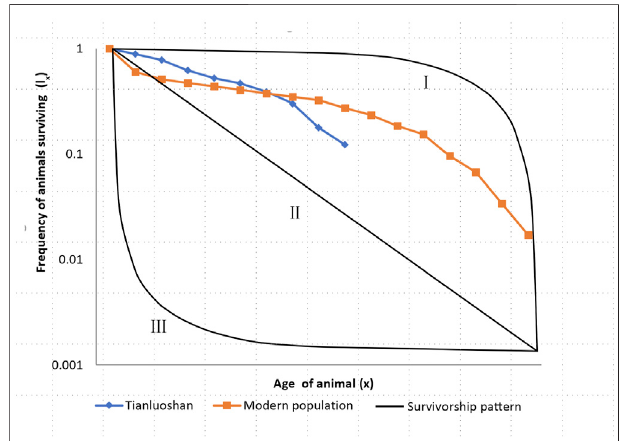
FIGURE 8 | The survivorship curves of Tianluoshan and modern sika deer. Thefrequencyofindividualssurvivingisplottedonalogarithmicscaleon the Y axis against the age of animal on the X axis. The survivorship curves Ⅰ , Ⅱ and Ⅲ are theoretical curves following Deevey (1947).